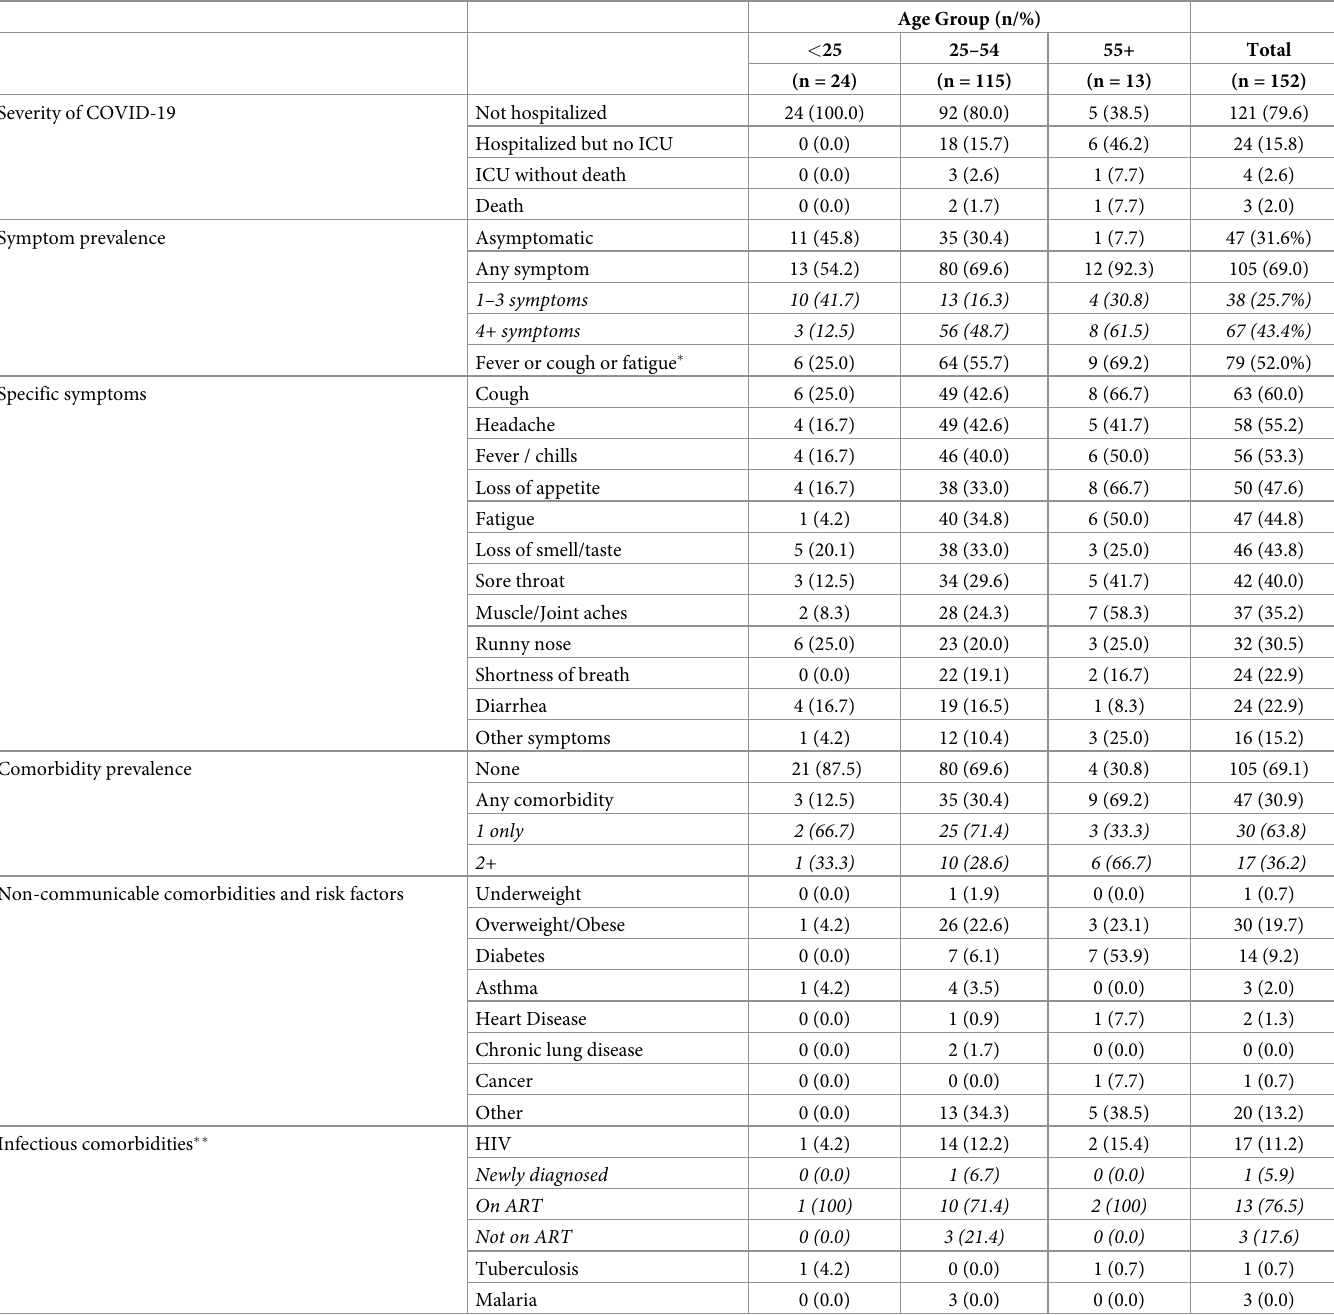
Table 2. Symptoms, comorbidities and severity of disease by age group, FFX study, Kisumu, Kenya, June-October